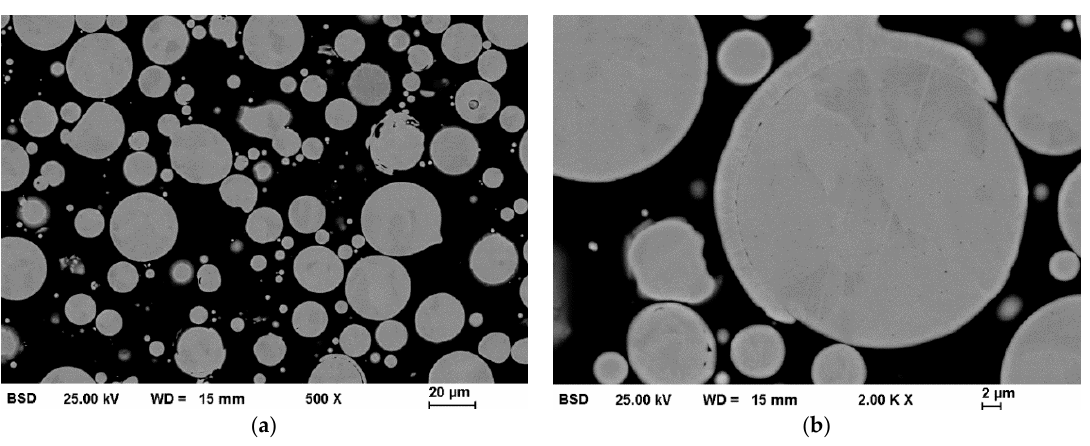
Figure 1. Scanning electron microscope (SEM) images (BSD) of inert gas atomised CrFeCoNi feedstock powder: ( a ) overview and ( b ) in detail.